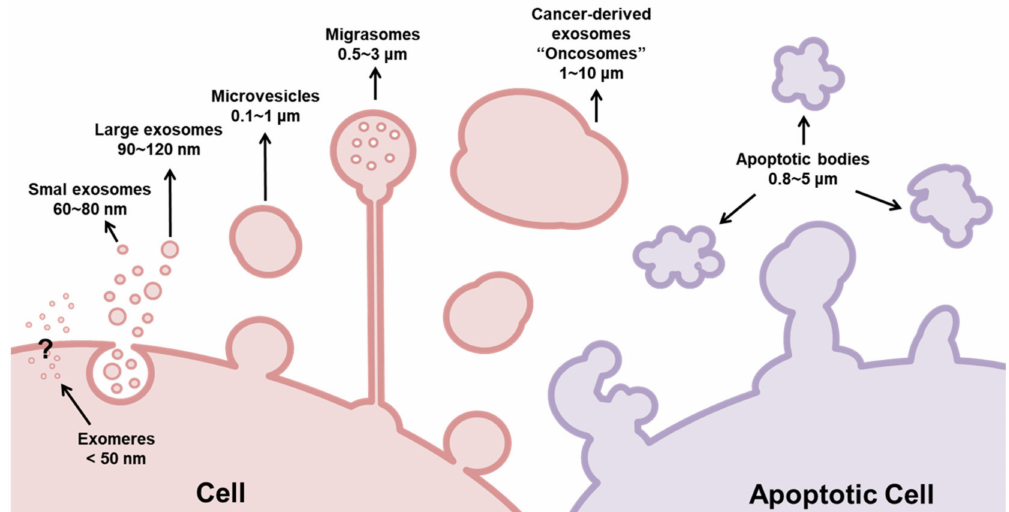
Figure 3. Classification of extracellular vesicles (EVs) according to their size. Basically, EVs are classified as exosomes (30–150 nm), microvesicles (100–1000 nm), and apoptotic bodies (800–5000 nm). While microvesicles and exosomes can operate as ‘safe containers’ mediating intercellular communication, apoptotic bodies appear after the disassembly of an apoptotic cell into subcellular fragments. Although they were previously regarded as garbage bags, emerging evidence supports the view that the apoptotic bodies are capable of delivering useful materials to healthy recipient cells. Different from exosomes, microvesicles are generated from the direct outward blebbing and pinching of the plasma membrane. Similar to exosomes, these vesicles carry proteins, nucleic acids, and bioactive lipids to recipient cells; however, they are larger than exosomes. Exosomes are conserved structures that originate as intraluminal vesicles during the assembly of multivesicular bodies, mediating cell-to-cell communication. However, current studies show that cancer-derived exosomes are larger than those secreted by normal/healthy cells. For this reason, these nanosized EVs were subclassified as exomers (<50 nm), small exosomes (60–80 nm), large exosomes (90–120 nm), and oncosomes (100–10,000 nm). Recently, a novel type of EV was described: migrasomes (500–3000 nm). Migrasomes are vesicular structures that mediate migracytocis, a cell migration mechanism mediated by these